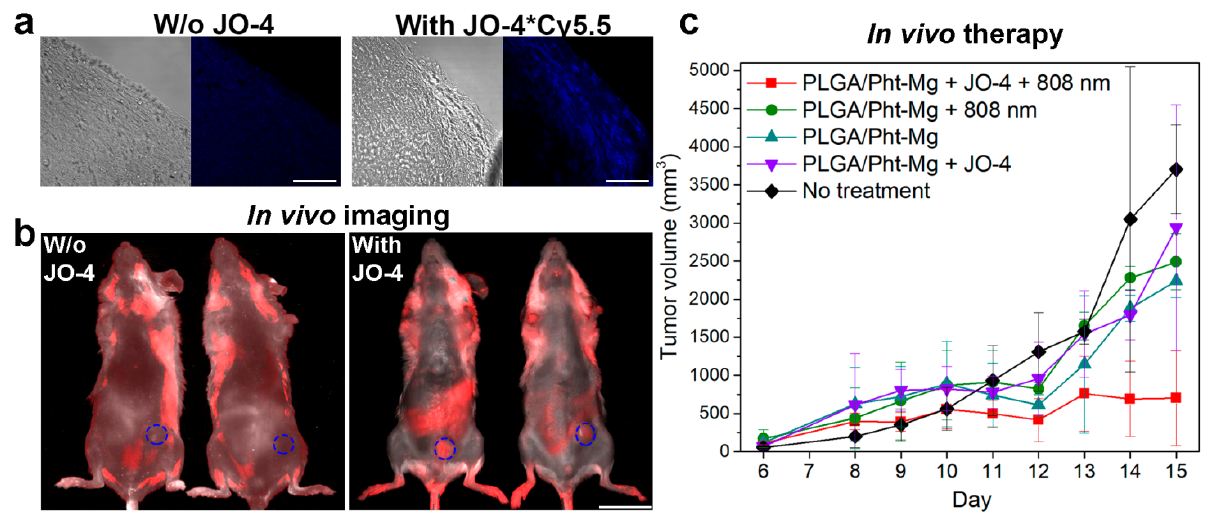
Figure 4. Targeting cancer cell junctions with JO-4 enhances the therapeutic and diagnostic capabilities of polymer PLGA-based photothermal sensitizers in vivo. ( a ) Cryosections of tumor tissue demonstrate the Cy5.5-labeled JO-4 ac- cumulation in the tumor. Confocal laser scanning microscopy images are presented in the fluorescence channel corre- sponding to the Cy5.5 fluorescence (excitation laser 640 nm, emission 660–760 nm) and in the bright field. Scale bars, 100 µm. ( b ) In vivo living imaging of BALB/c mice with orthotopic tumors i.v. injected with PLGA/Pht-Mg particles with or without pre-injection of JO-4 in the fluorescence channel corresponding to the nanoparticle’s fluorescence. Scale bar, 2 cm. ( c ) Tumor growth dynamics under the treatment with PLGA/Pht-Mg particles with or without JO-4 pre-treatment and with or without 808 nm laser irradiation. Data are presented as mean ±